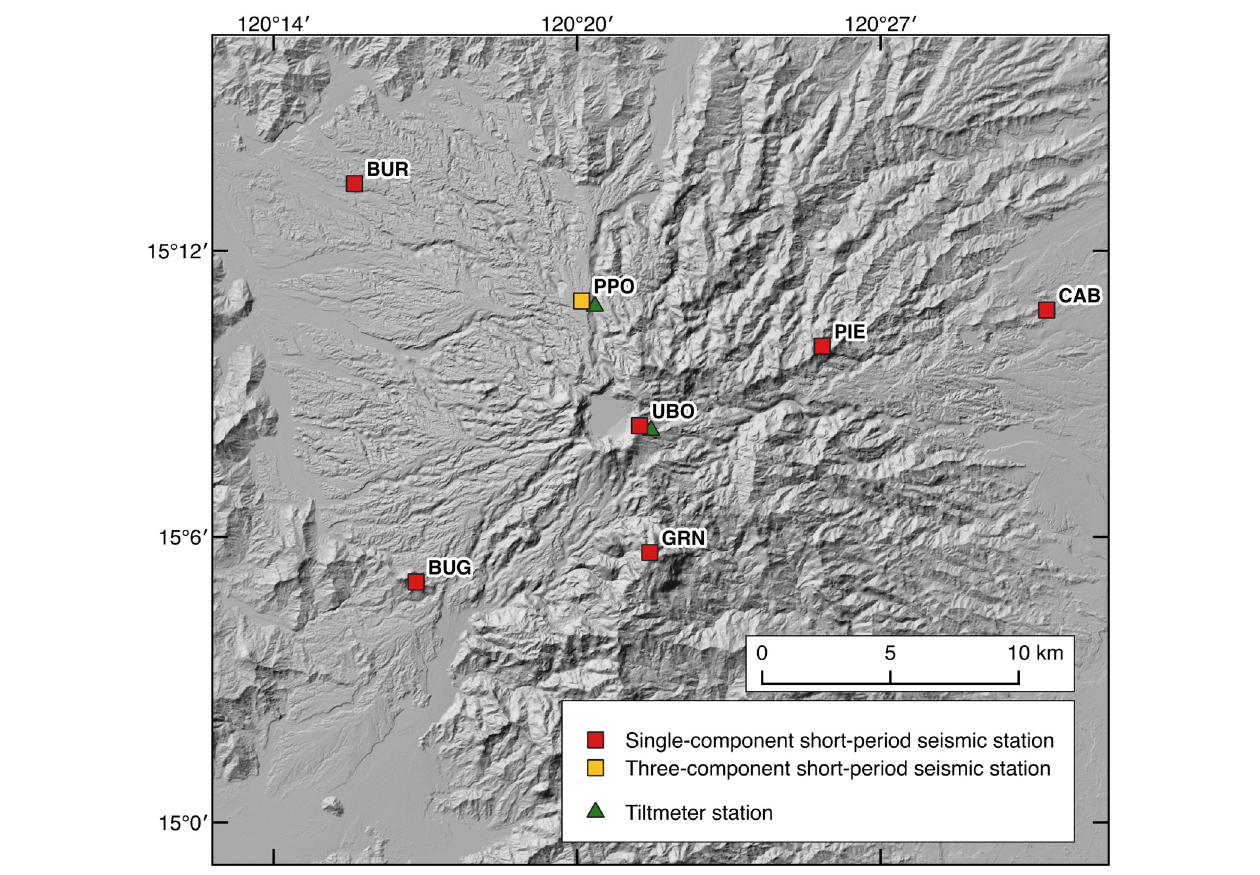
FIGURE 6 | Map showing seismic and tiltmeter stations installed at Mount Pinatubo during April–early May 1991, prior to the climactic eruption on June 15, 1991. Seismic station locations are from Lockhart et al. (1996). Tiltmeter station locations are from Ewert et al. (1996). See original publications for additional details. Hillshade is an ESRI Image Service product from 2013 accessed through ArcGIS Online and depicts post-1991 topography.